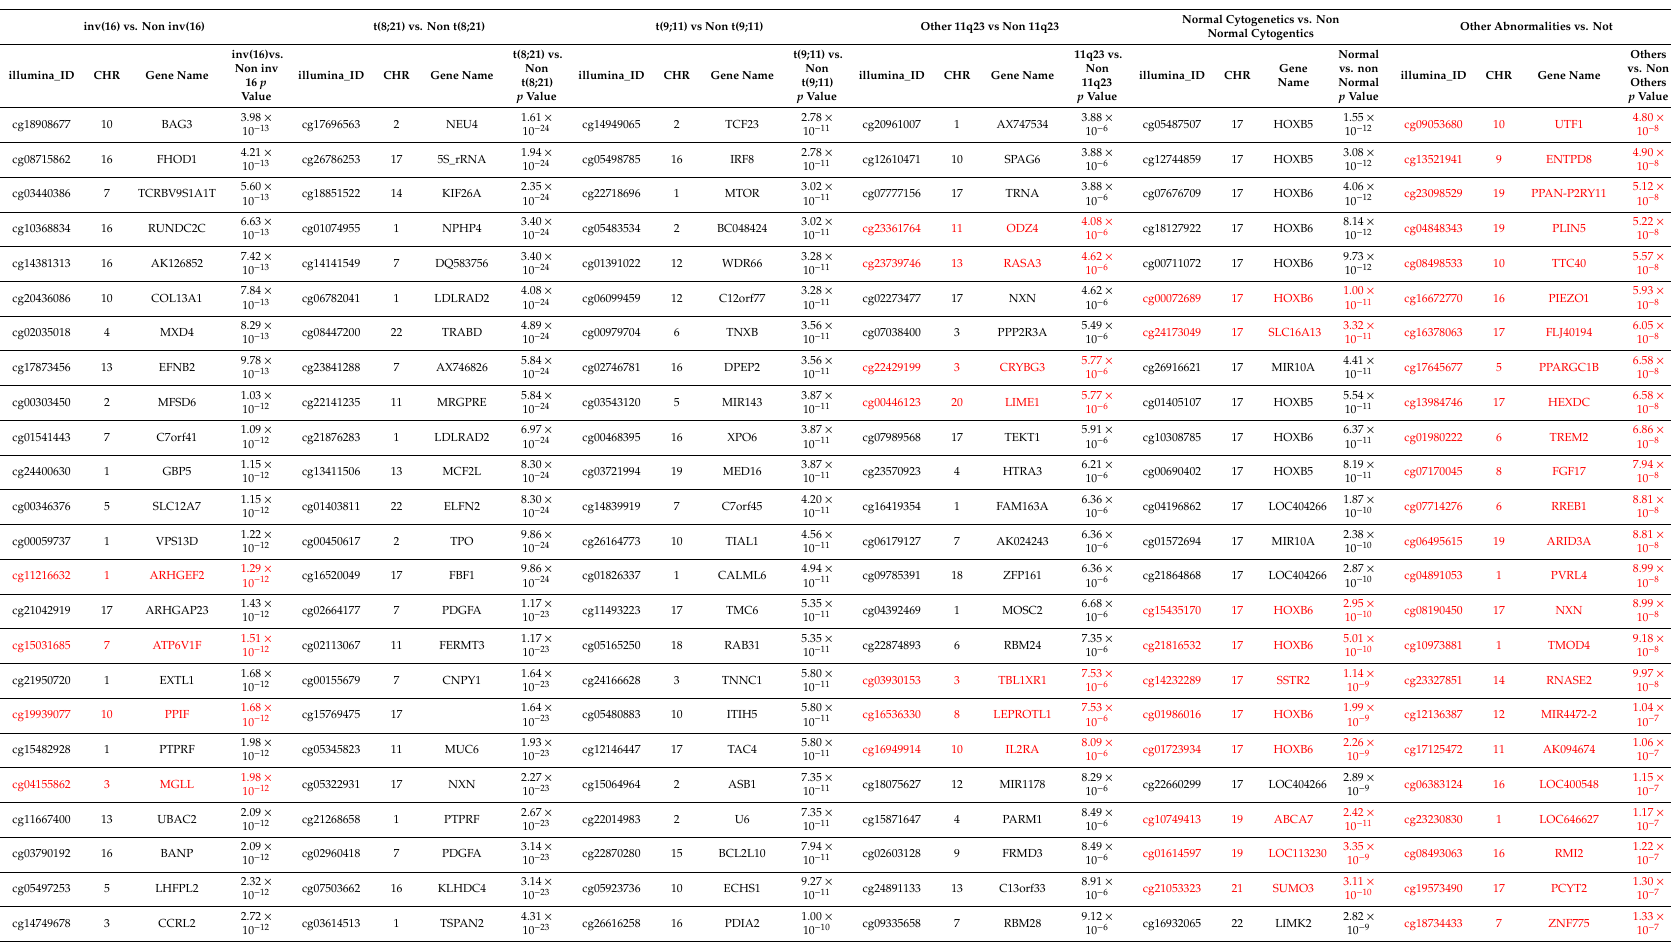
Black Font: Genes hypomethylated in the selected cytogenetic group as compared to other. Red Font: Genes hypermethylated in the selected cytogenetic group as compared to